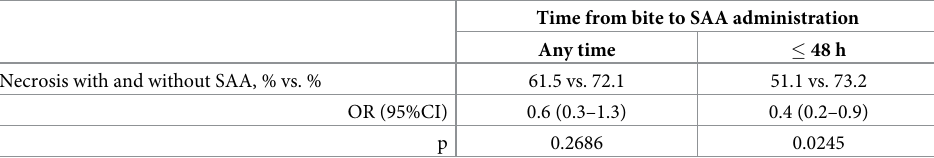
Time from bite to SAA administration Any time � 48 h